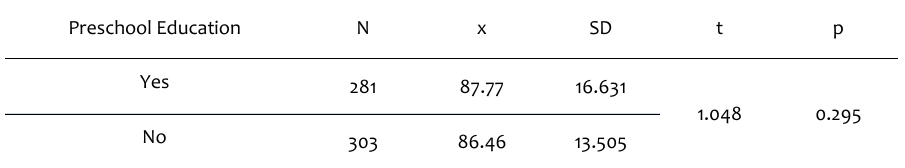
Table 2. Students' reading motivation scores in relation to receiving preschool